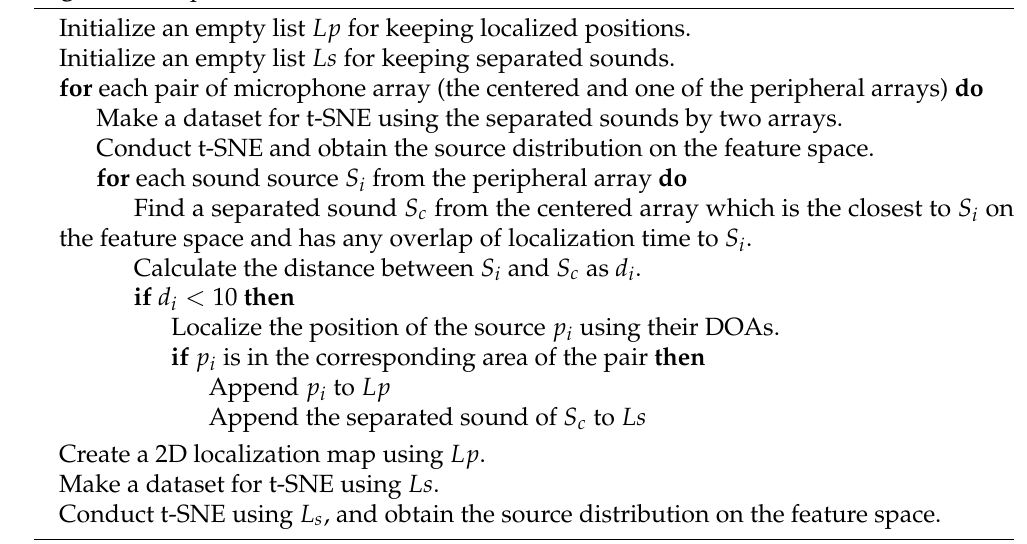
Figure 5. Spatial division of the tent area for 2D localization. For each area, we conducted 2D localization by using a pair of microphone arrays: array 4 (central) was always included, and was paired with one other array based on the target localization area (color-matched above). For each sound source from array 4, source localization is performed using the combination of sources with the closest distance in the feature space of t-SNE. Algorithm 1 Spatial division-based 2D